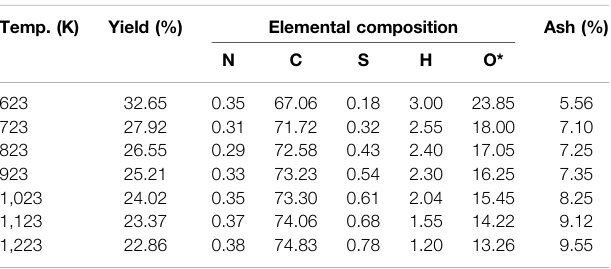
TABLE 1 | Effect of temperature on the elemental composition of chars from bamboo. Temp. (K) Yield